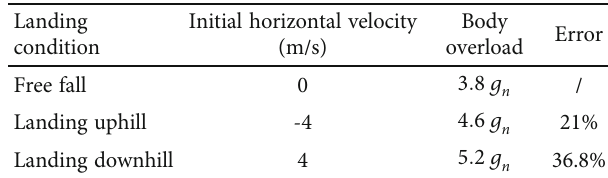
Figure 5: Maximum overload vs. initial horizontal velocity. Table 4: Impact of initial horizontal velocity landing conditions on the maximum overload of the body.